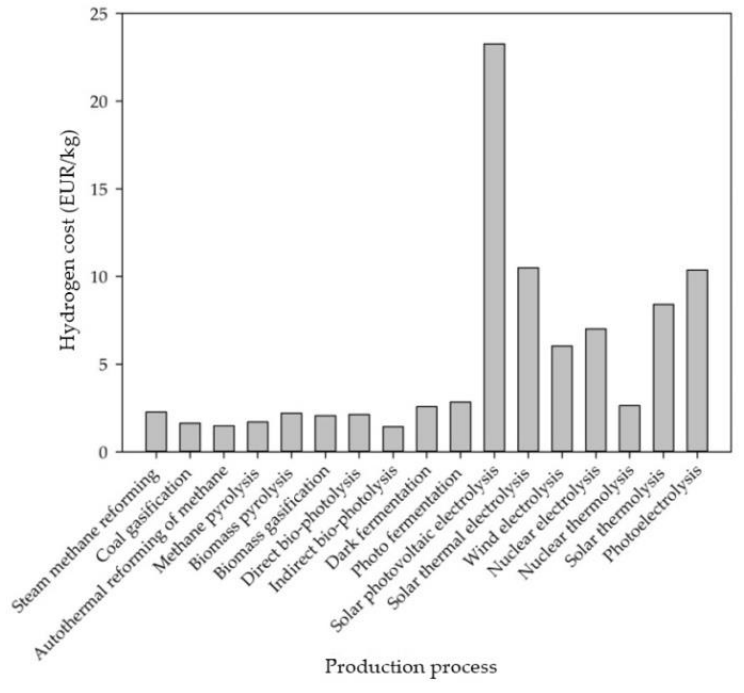
Figure 2. Hydrogen costs based on different production processes [7].